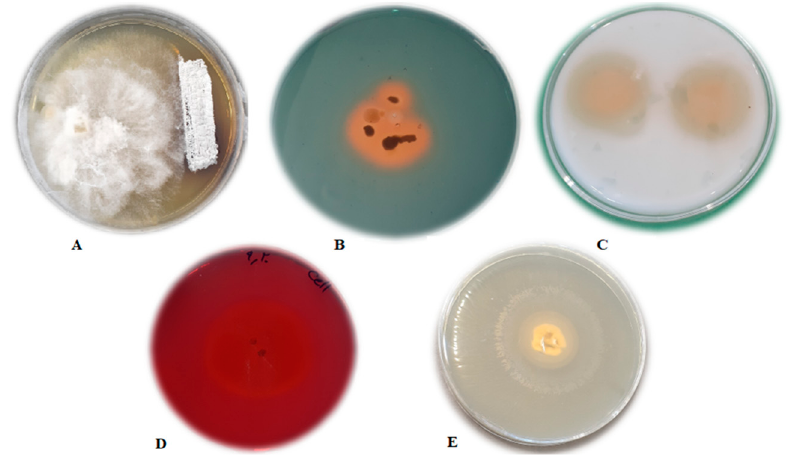
Figure 1. ( A ) Inhibition zone; ( B ) production of siderophores; ( C ) protease production; ( D ) cellulase production; ( E ) lipase production.